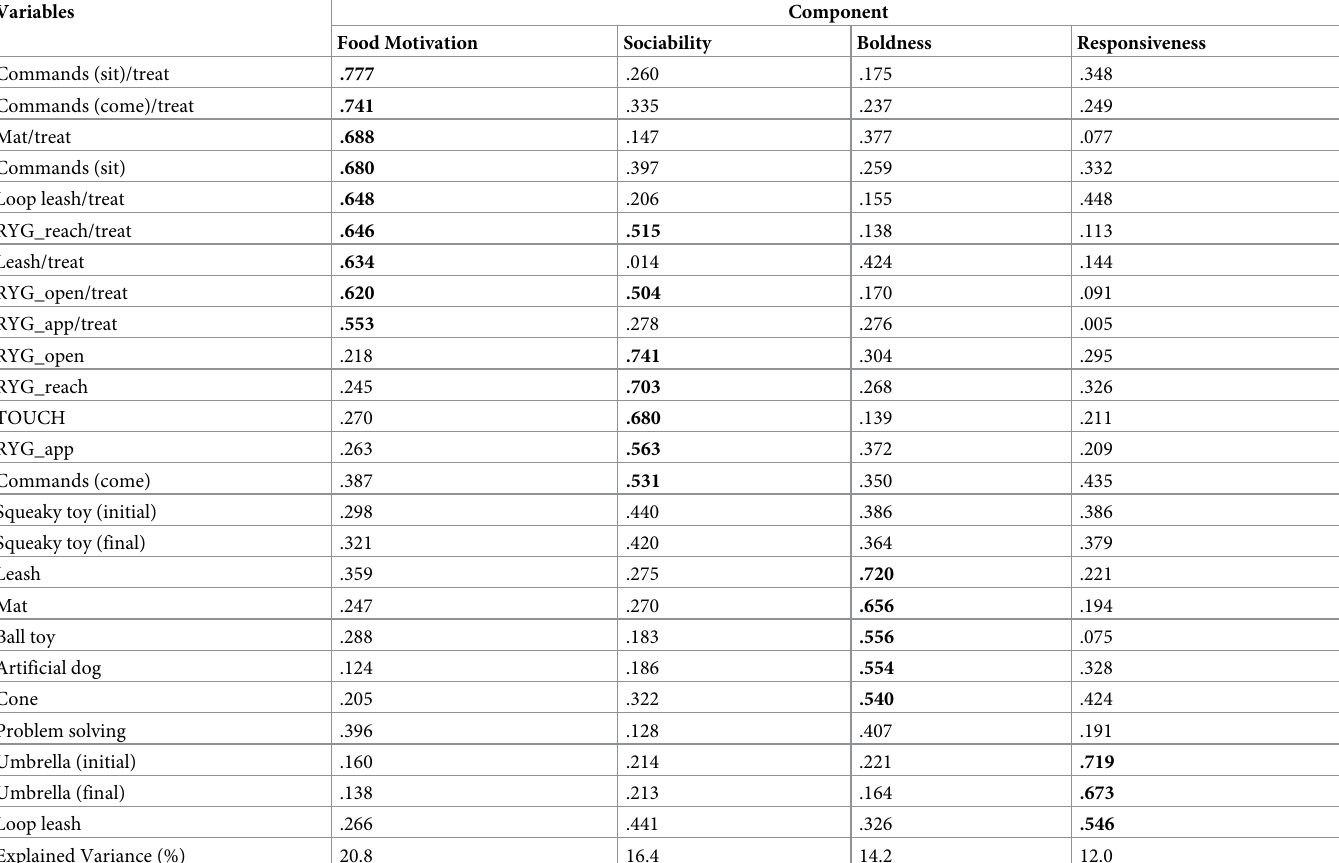
Table 5. Dimensions extracted by the Exploratory Factor Analysis (EFA).